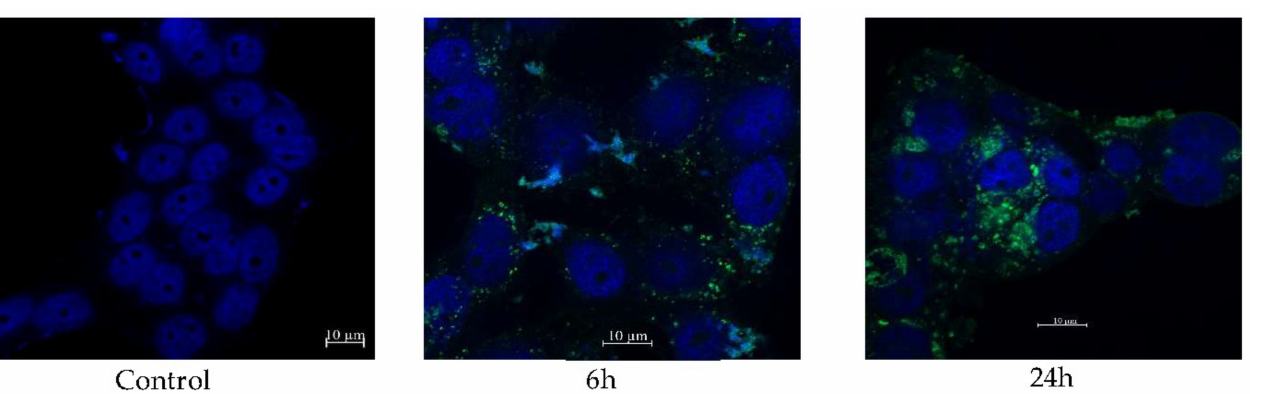
Figure 9. CLSM analysis of NBSCh micelles uptake by human colon cancer cells (HT-29) 6 h and 24 h after exposure. Blue fluorescence represents the cell nuclei stained by Hoechst 33,342 stain. Green fluorescence represents the micelles labelled by